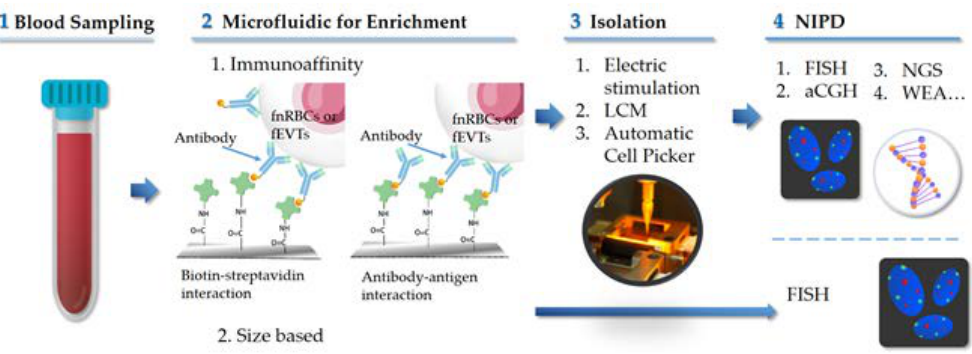
Figure 1. Schematic of laboratory process of NIPD based on microfluidic technology. :antibody;